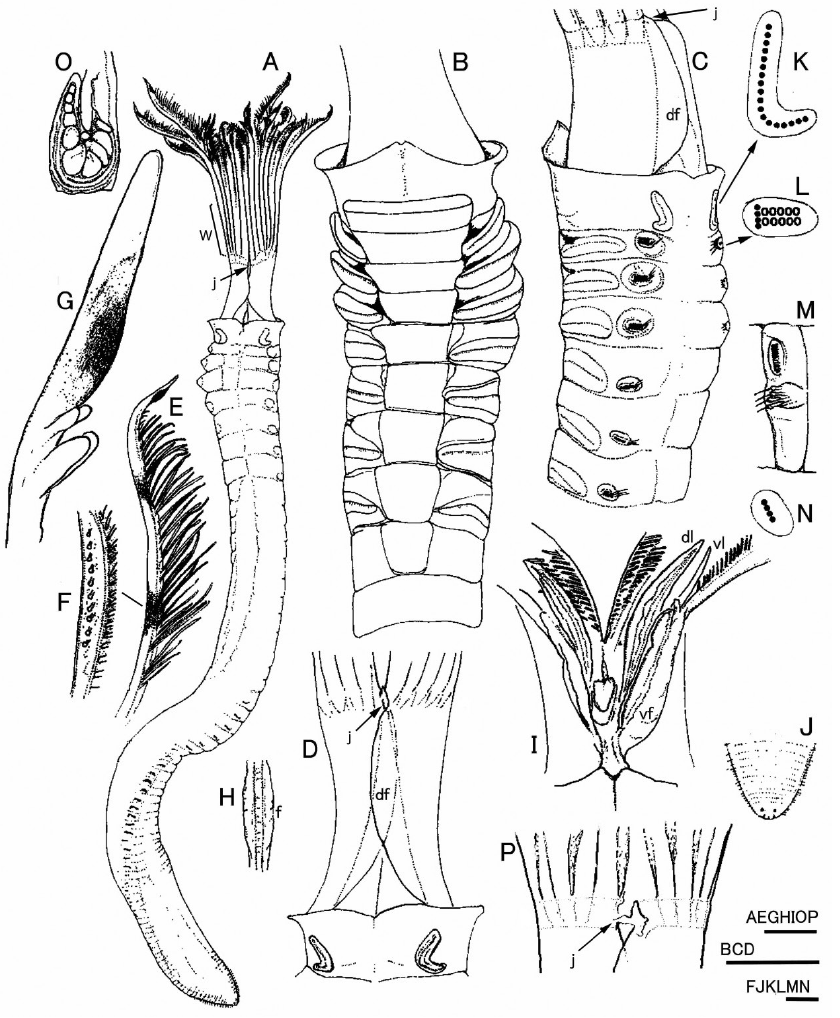
Figure 1. Notaulax yamasui sp. n.: A holotype, dorsal view B ventral view of thorax C latero-dorsal view of left side of thorax D dorsal view of first chaetiger and radiolar base E distal side view of radiole F mid- dle region of radiole showing a row of simple radiolar eyes G lateral close up view of tip of radiole, with pigmented sub-distal swelling H basal part of radiole showing paired longitudinal flanges (f) I schematic ventral view of interior of crown showing dorsal lip (dl), ventral lip (vl), ventral flange of radiolar base margin (vf) J posterior abdomen and pygidium, showing eye-spots K schematic arrangement of collar chaetae, right side L schematic arrangement of thoracic chaetae from second chaetiger, black spots rep- resenting superior chaetae, white circles representing inferior chaetae M anterior abdominal segment, left side view N schematic arrangement of neuropodial abdominal chaetae O cross-section of radiole, middle region P base of radioles and inter-radiolar membrane. Abbreviations: df, dorsal basal flange; dl, dorsal lip; f, longitudinal flange; j, junction of dorsal basal flange; vf, ventral flange; vl, ventral lip; w, inter- radiolar membrane. Scale bars 1 mm ( A, B, C ), 0.5 mm ( D, J ), 0.25 mm ( E, F, H, K, P ), 0.1 mm ( G, I, L, M, N, O